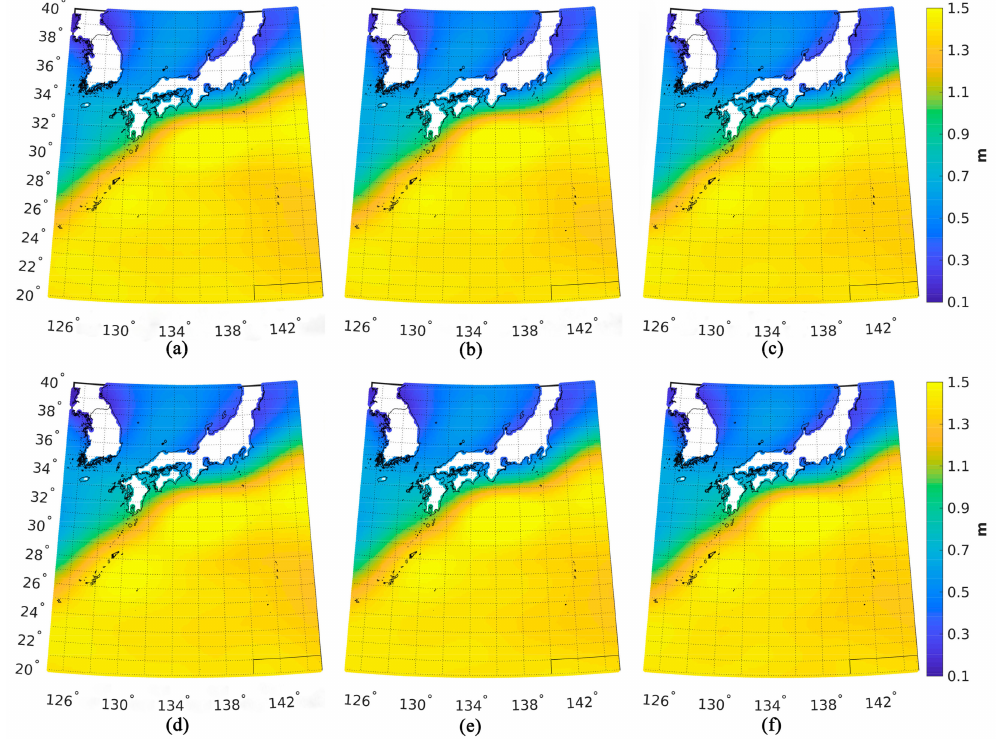
Figure 4. The estimated MDT based on ( a ) DIRR4, ( b ) DIRR5, ( c ) DIRR6, ( d ) TIMR4, ( e ) TIMR5, and ( f )